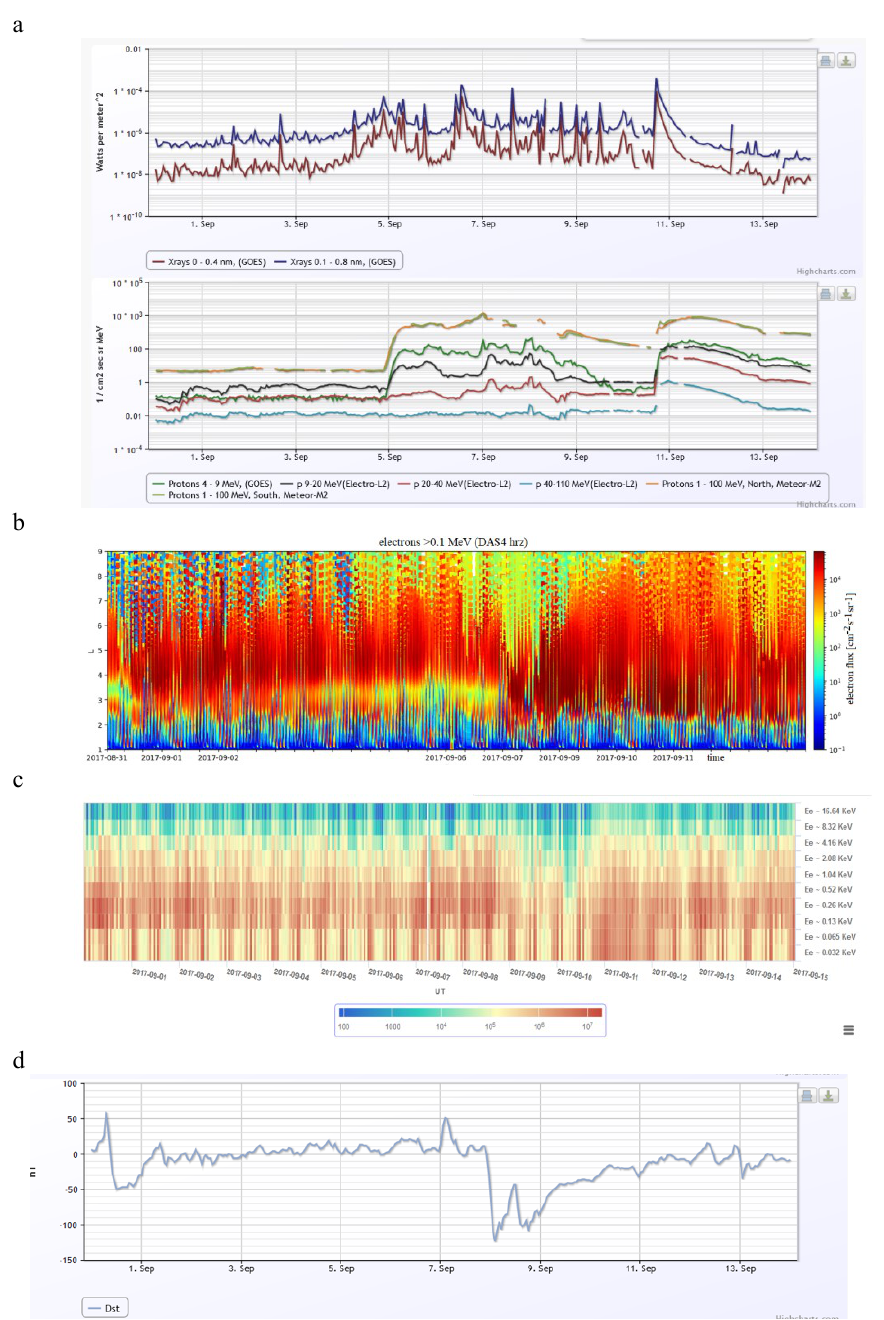
Fig. 3. Event detected 1 -15 September, 2017. Time profile of the intensity of X-rays from the sun according to GOES data (a, upper panel), SCR fluxes in the GSO and in the polar cap according to GOES data, Electro L2, SKIF instrument, Meteor, SCR instrument (a, lower panel), electron fluxes in ERBs according to Meteor data, MSGI instrument (b), spectrogram of auroral electron fluxes, Meteor-MSGI (c), time variation of D st